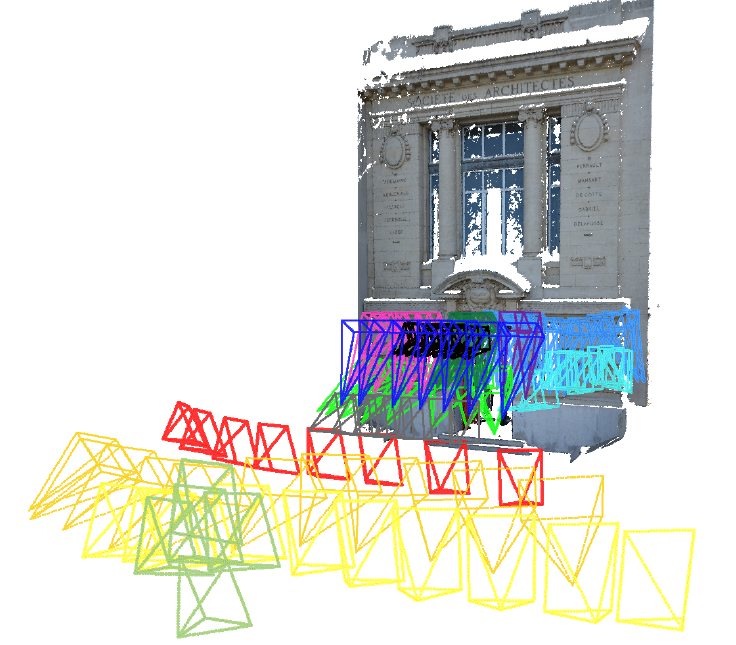
Figure 6. SA13 dataset : example of complex multi-focal processing (each color represents a new